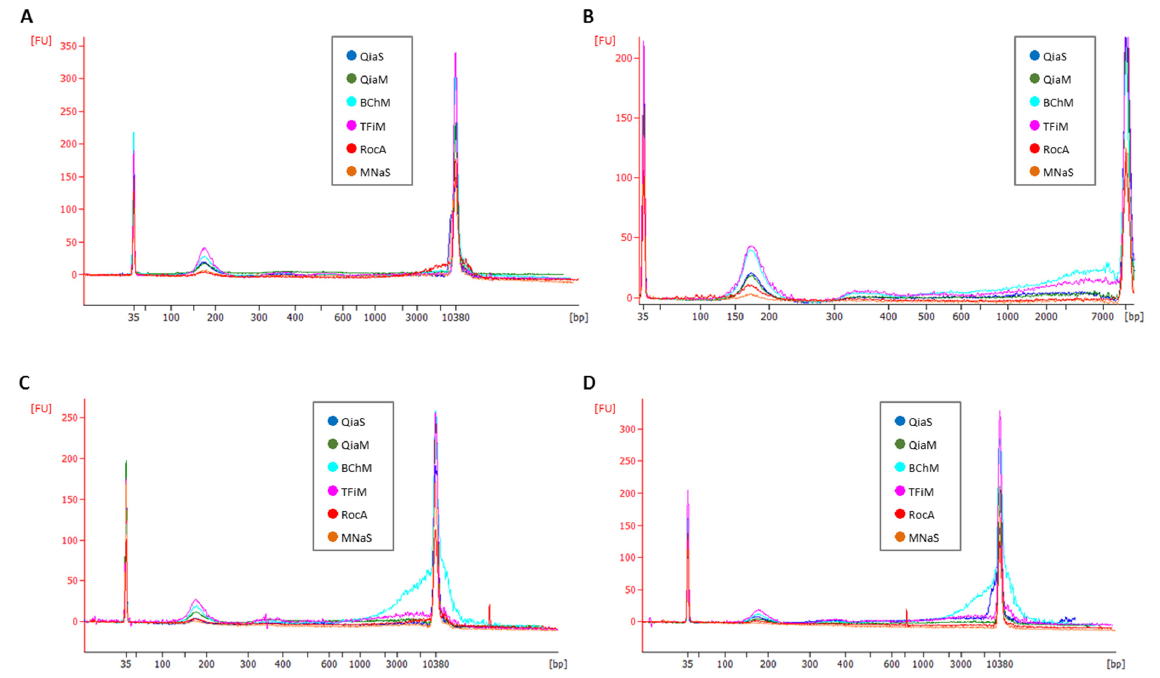
Figure 3. Cell-free DNA (cfDNA) size profiles yielded by different extraction kits. ( A-D ) Representa- tive electropherograms from 4 of the 10 donors, as measured with the Agilent HS DNA Kit on the 2100 Bioanalyzer. The curves in these figures are not representative of the total cfDNA yield by the respective kits, as different elution volumes were used for the different extraction kits (100 µL for RocA, 50 µL for QiaS and QiaM and 30 µL for TFiM and BChM).